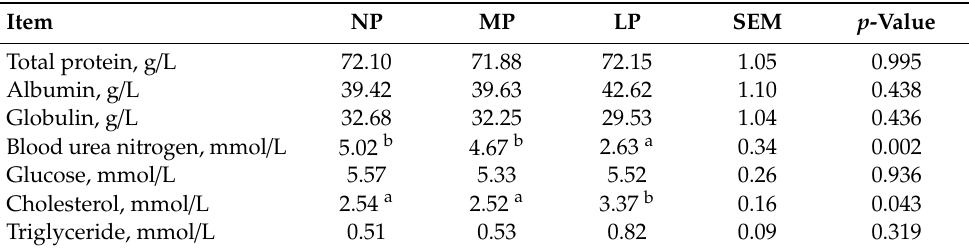
Table 2. E ff ect of dietary protein level on blood biochemical indices of pigs.